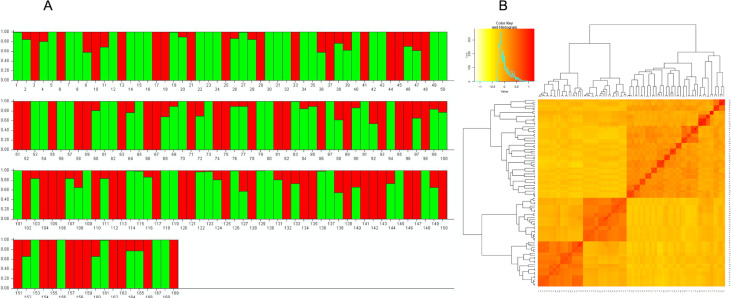
Population structure of the study panel.A The two distinct clusters found in 169 wheat bulked samples used in this study. The green bars represent 102 winter-type bulked samples and the red bars represent 67 spring-type bulked samples. B Kinship matrix depicting relatedness among the genotypes.